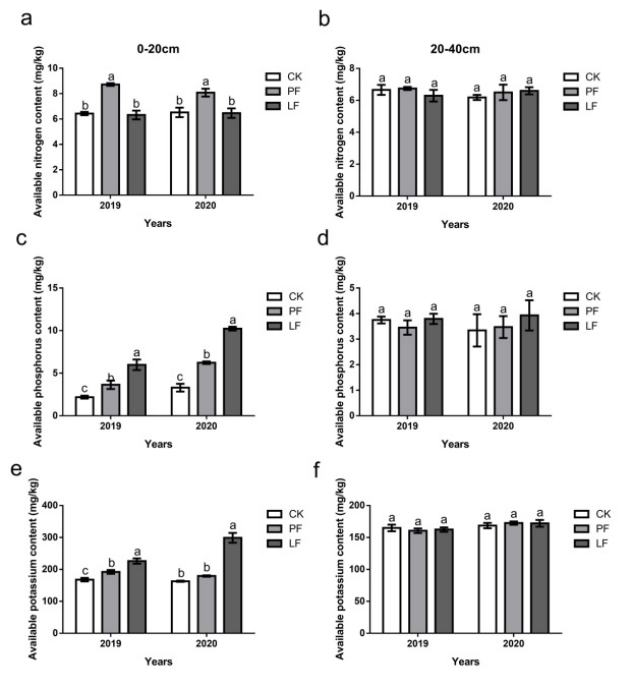
Figure 4. Effects of in-row mulching on the available nutrients of the soil in 2019 and 2020. ( a ): Available nitrogen content (0–20 cm); ( b ): Available nitrogen content (20–40 cm); ( c ): Available phosphorus content (0–20 cm); ( d ): Available phosphorus content (20–40 cm); ( e ): Available potassium content (0–20 cm); ( f ): Available potassium content (20–40 cm). Different letters above the columns indicate significant differences between treatments in Duncan's multiple comparisons ( p < 0.05) .